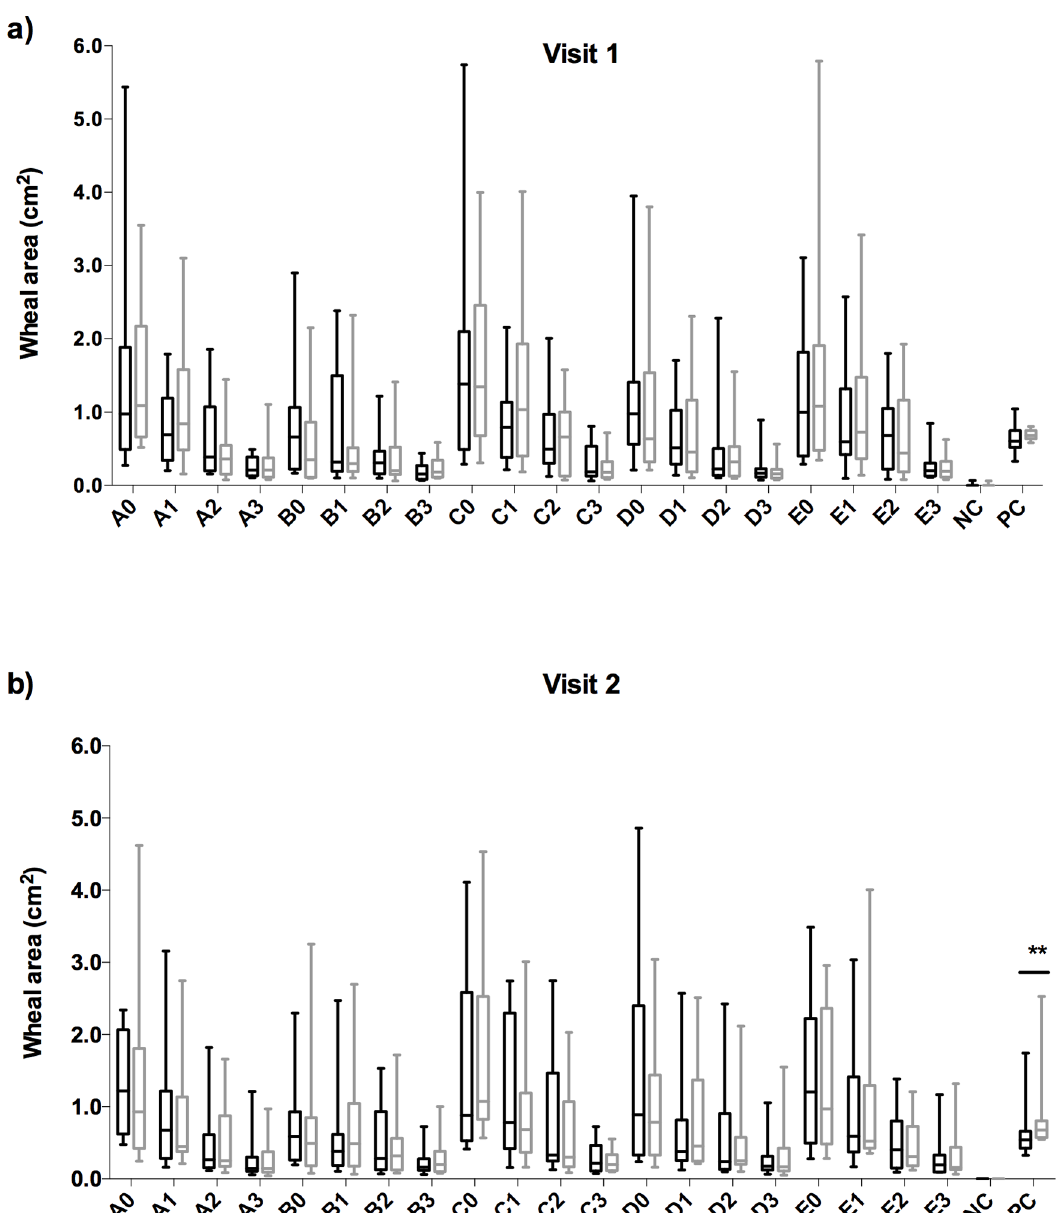
Fig 1. SPT left and right forearm comparison. Evaluation of the reliability of SPT with allergen extracts in 14 grass pollen allergic rhinitis patients at visit 1 (a) and visit 2 (b) . Box plots indicate median of SPT wheal surface areas (cm 2 ) on the left (grey boxes) or right forearm (black boxes). 5 preparations of grass pollen extracts were used: A) Staloral 1 300 IR/mL Phleum pratense pollen exact; B) Oralair 1 300IR 5-grass pollen extract SLIT tablet, diluted in 1ml 50% glycerin; C) Soluprick 1 Phleum pratense pollen exact for SPT; D) Grazax 1 Phleum pratense pollen extract SLIT tablet, diluted in 1ml 50% glycerine; E) Reference Greer 1 10.000 BAU/mL Phleum pratense pollen extract in different dilutions (E0: concentrated, E1: 1:3, E2: 1:10, E3: 1:30); vehicle negative control (NC) and histamine 1mg/ml positive control (PC). (cid:3)(cid:3) p (cid:20)